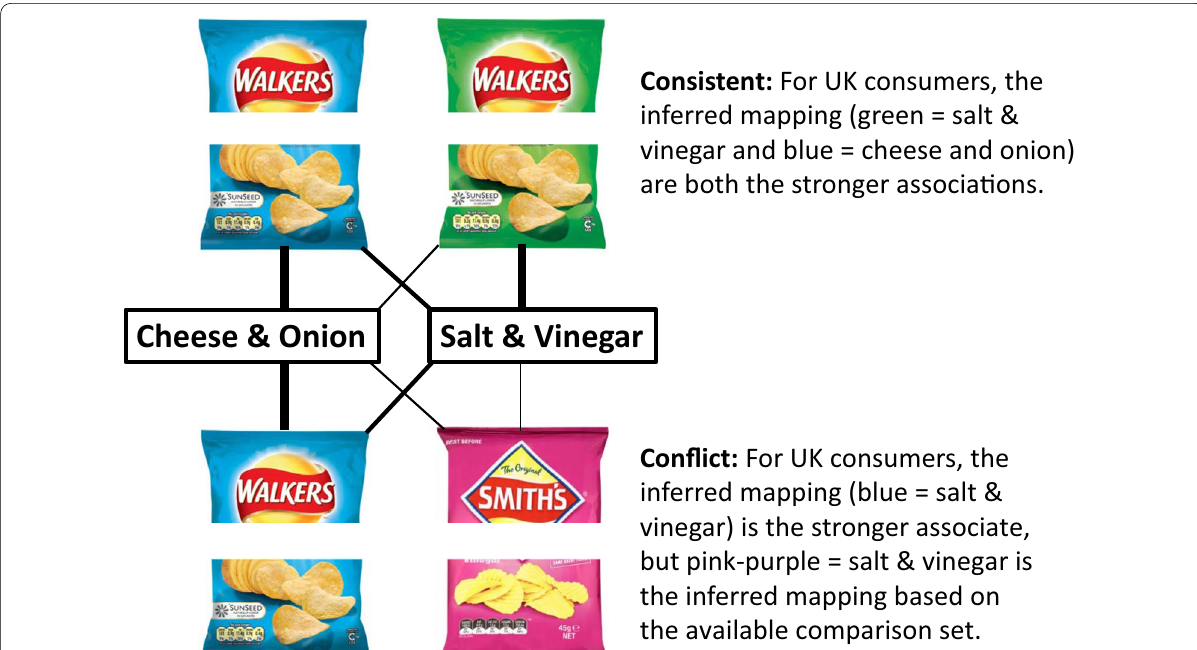
Fig. 1 Distinction between colour–flavour associations and inferred mappings, showing colour–flavour association strengths for flavours ‘Cheese and onion’ and ‘Salt and vinegar’ with crisp packaging colours blue, green, and pinkish-purple (thicker lines connecting flavours with colours indicate stronger associations). What such a hypothetical situation highlights is how the colour–flavour mapping may result from inference rather than direct association. Figure adapted from Schloss et al.